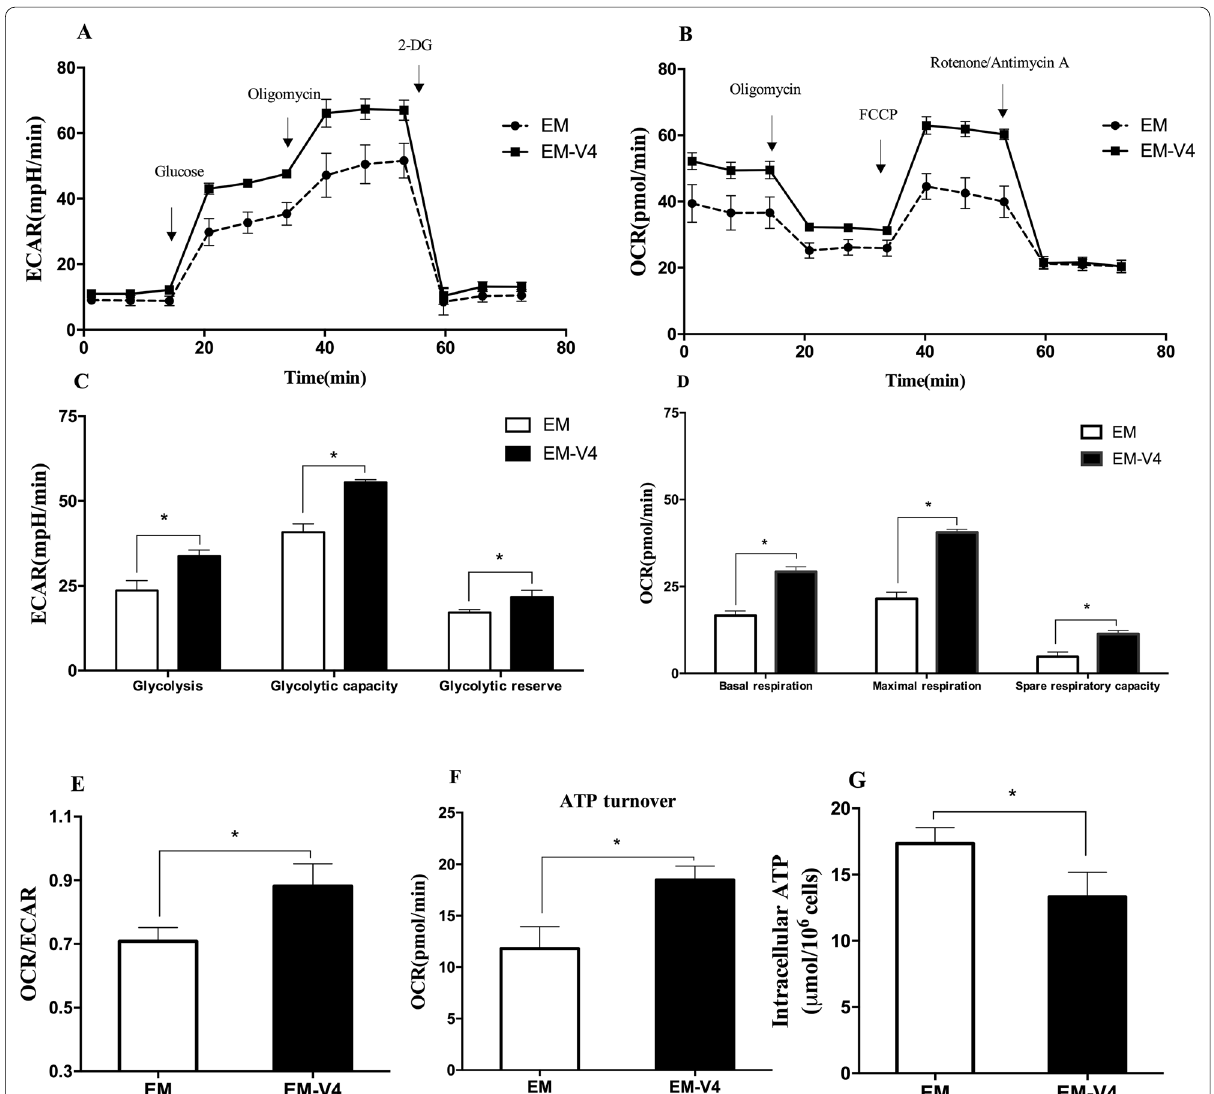
Fig. 4 Extracellular acidification rate (ECAR) and oxygen consumption rate (OCR) of NK‑92 cells. A ECAR of the glycolytic rate. B OCR of mitochondrial oxygen consumption rate. C Basal ECAR, glycolytic capacity and glycolytic reserve of the cells. D Basal OCR, maximal respiration and spare respiration capacity of the cells. E OCR/ECAR ratio. F ATP turnover. G Intracellular ATP level. (* P < 0.05, n